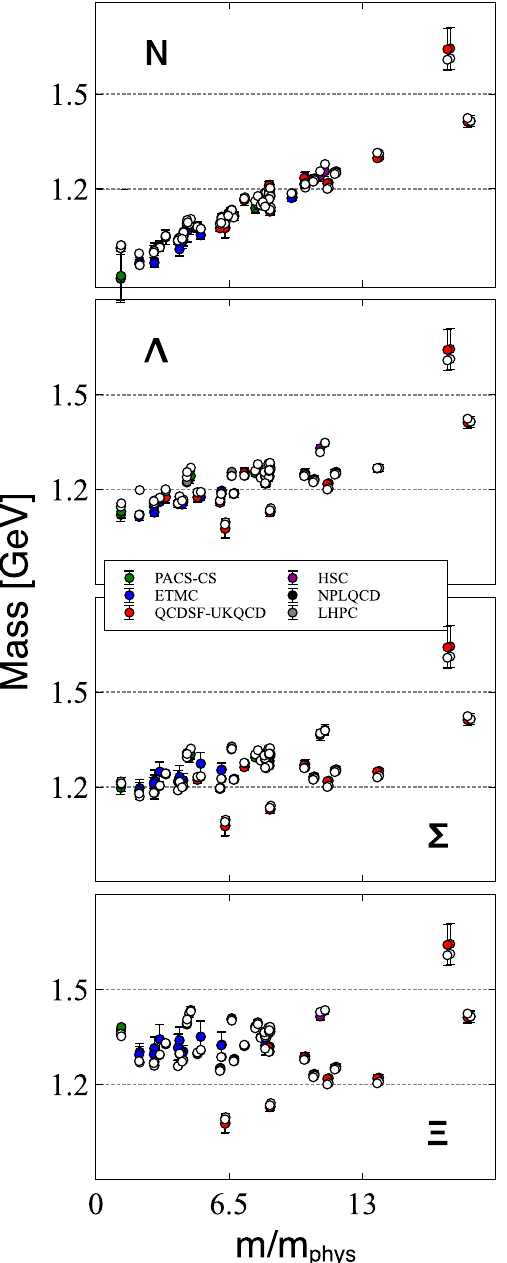
Fig. 1 Baryon octet masses as a function of the light quark mass m = m u = m d . The results from Fit 1 and Fit 2 (empty circles) are compared to the results from various lattice groups (colored circles)